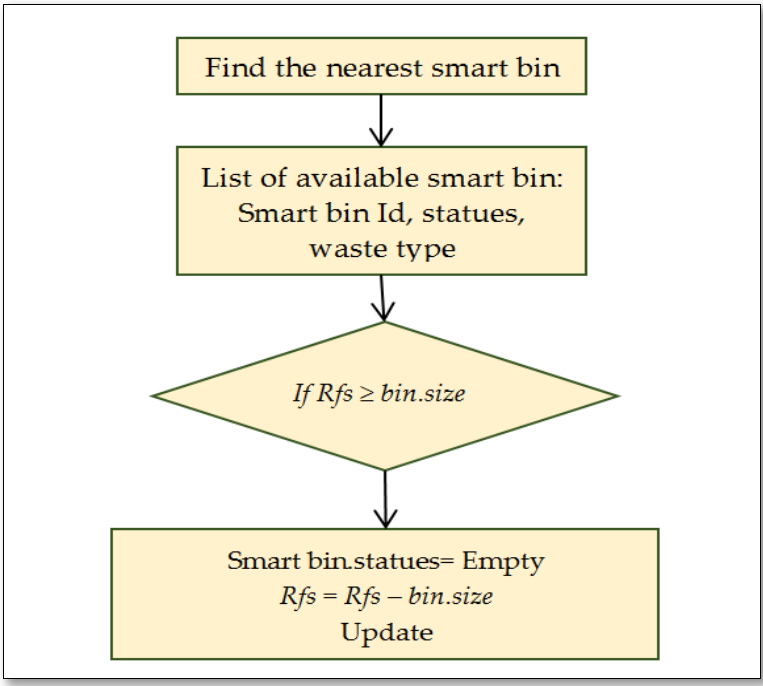
Figure 13. Flowchart of manual collection .